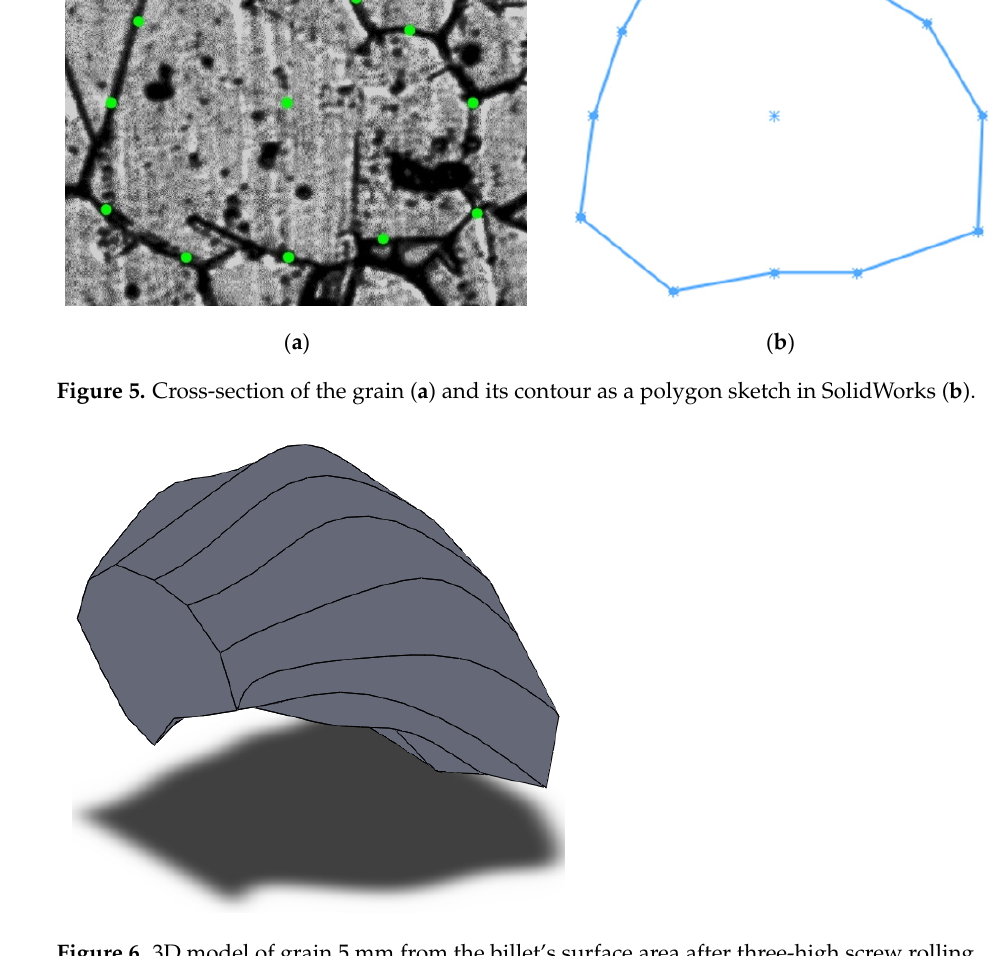
Figure 6. 3D model of grain 5 mm from the billet’s surface area after three-high screw rolling.